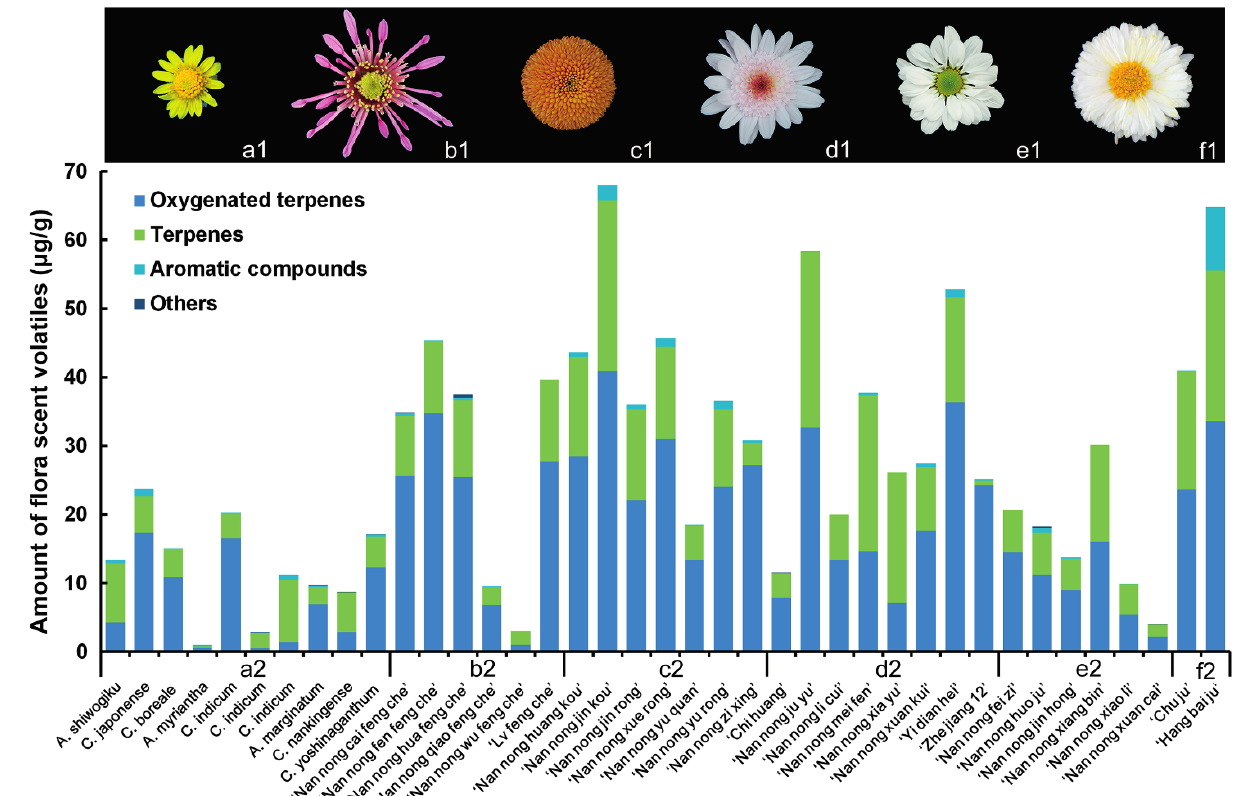
Figure 1. Representative different flower types of Chrysanthemum and chemical composition of flower headspace volatiles. ( a ) Wild relatives; ( b ) spider type; ( c ) pompon type; ( d ) anemone type; ( e ) single-flower; ( f ) double-flowers. Individual stacked bars reflect the relative composition of flower volatiles by chemical